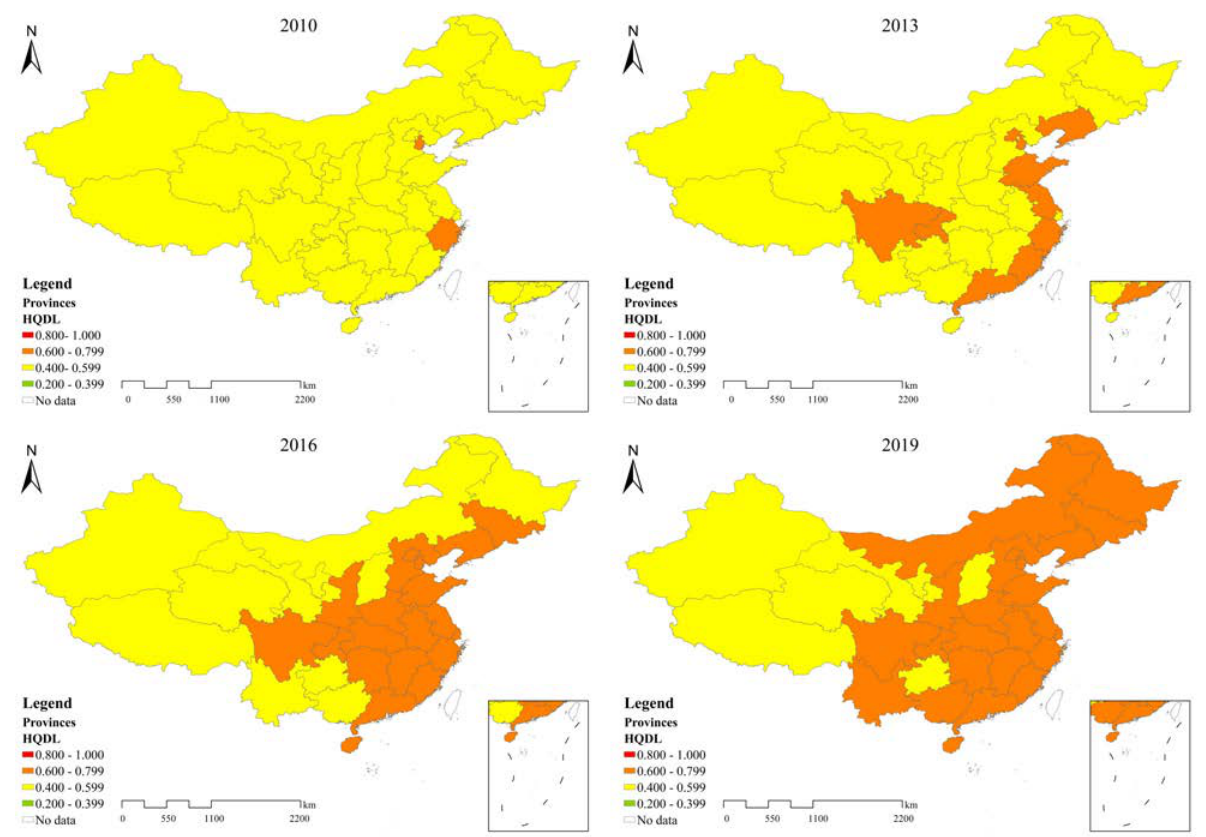
Figure 8. Spatial distribution of HQDL of 31 PLARs in 2010, 2013, 2016, and 2019.